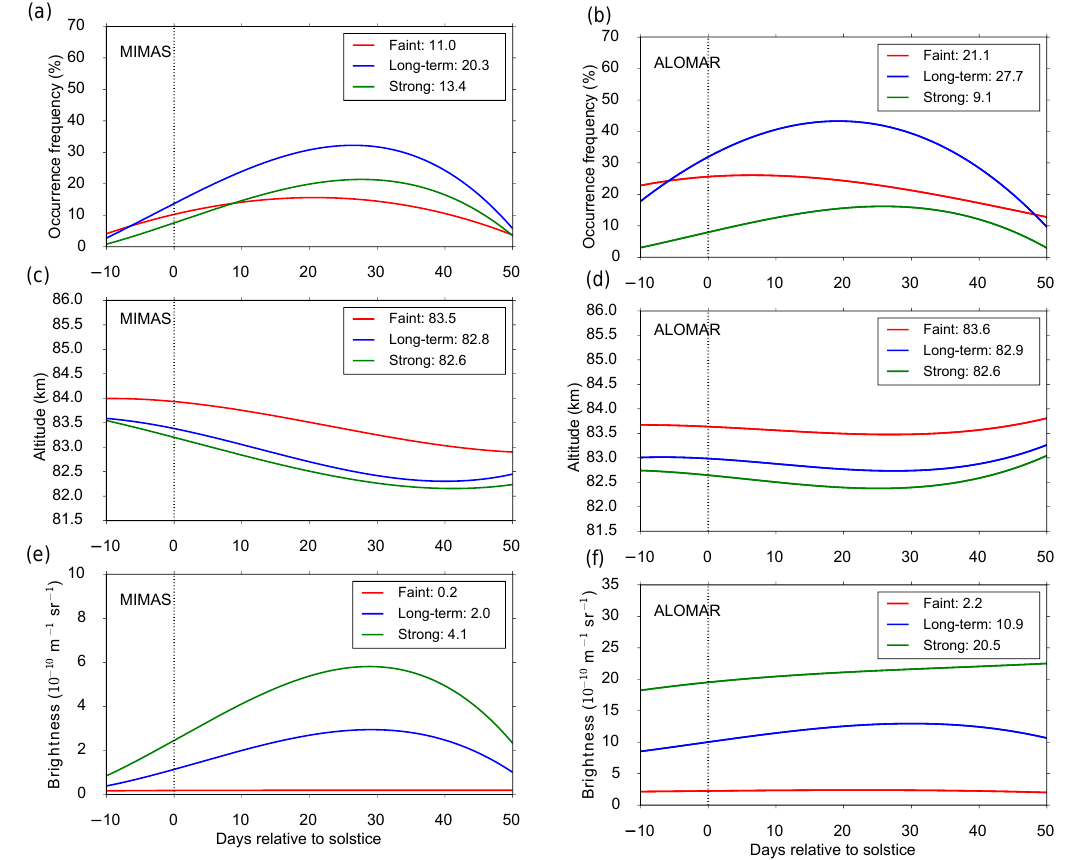
Figure 3. Mean seasonal variations of PMC occurrence frequency (a, b) , altitude (c, d) , and brightness β max (e, f) between 2003 and 2013 at ALOMAR for faint (red), long-term (blue), and strong (green) clouds (for details see text). Panels (a, c, e) show model results for 67–71 ◦ N, 10–20 ◦ E; panels (b, d, f) show lidar observations from ALOMAR. The solid lines represent third-order polynomial fits based on daily means. Numbers in the figure legends are seasonal mean values. Brightness ranges for cloud classes are scaled down by a factor of 4 for MIMAS results. Note the different scaling of the brightness axis for model and lidar